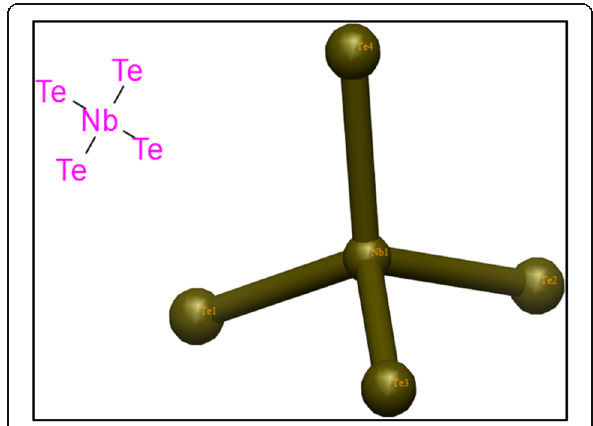
Fig. 10 Structure of niobium-doped telluride (NbTe 4 ) in 2D and 3D view